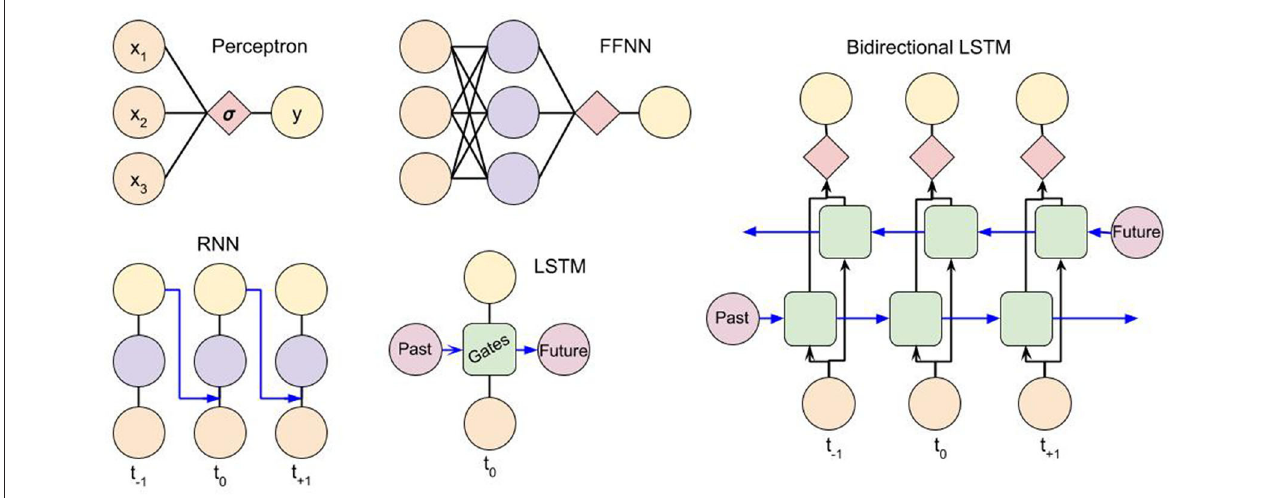
FIGURE 2 | Evolution of the non-linearity and time-dependence of neural network models that make up the bidirectional Long Short Term Memory GLS magnetopause